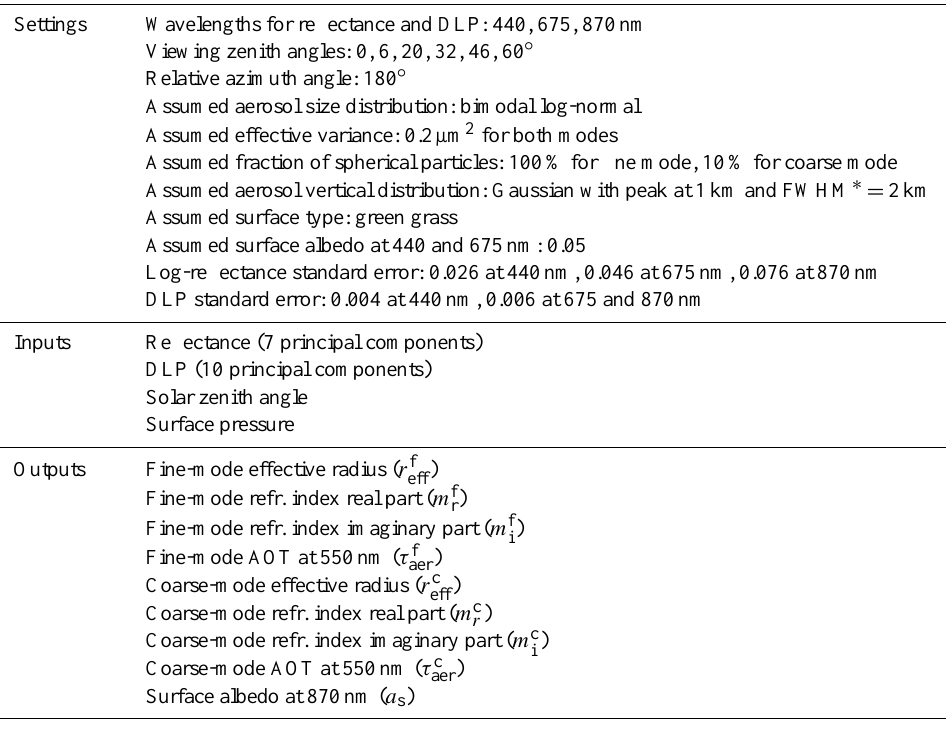
algorithm (Rumelhart et al., 1986) accelerated by means